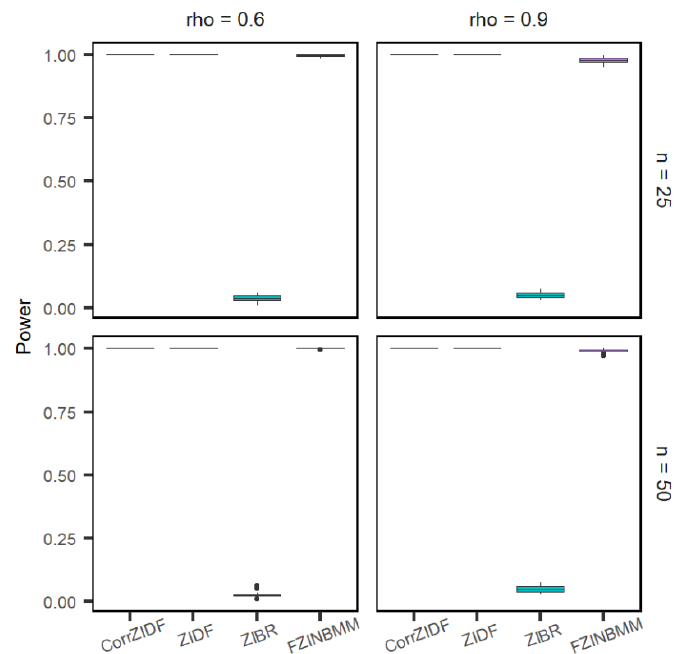
Figure 1. Boxplots for the power under various settings based on 20 replicated simulations with 1000 features (including 200 DAFs) after adjusting multiple comparisons. The p -values are adjusted by the BH procedure. Assume AR (1) correlation structure across different sampling points.